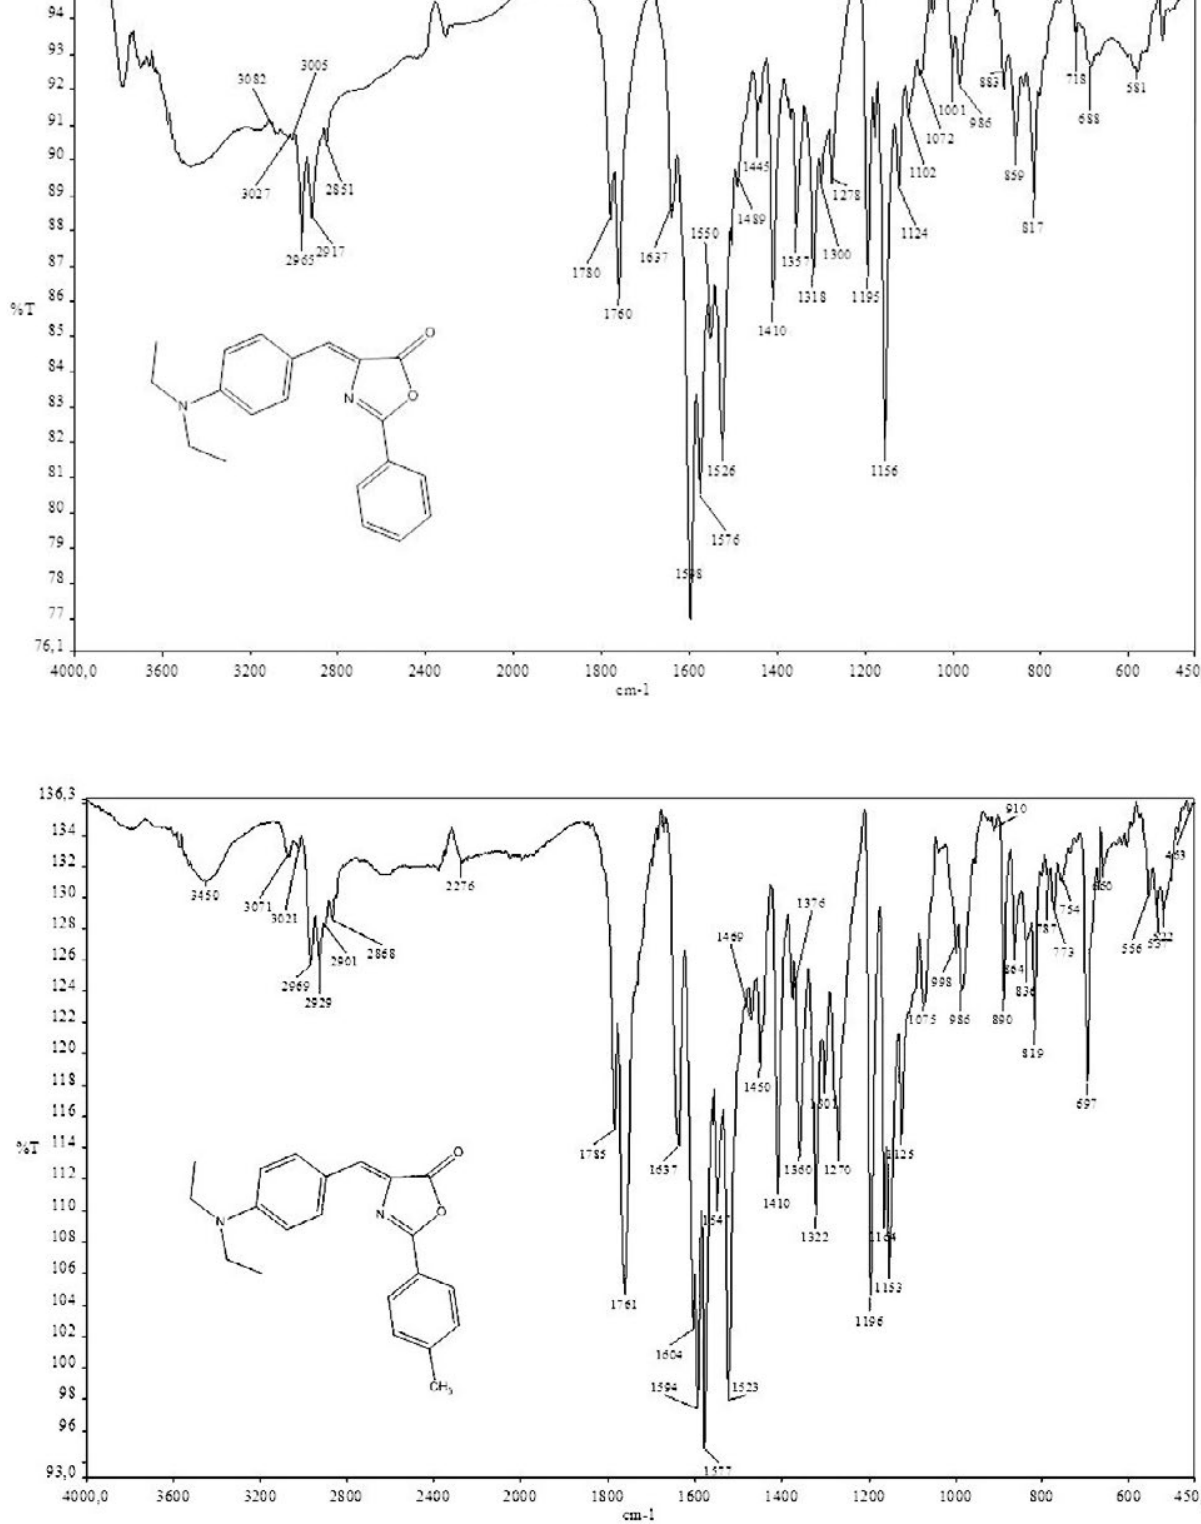
Figure 6. IR spectra of the title compounds 1 (above) and 2